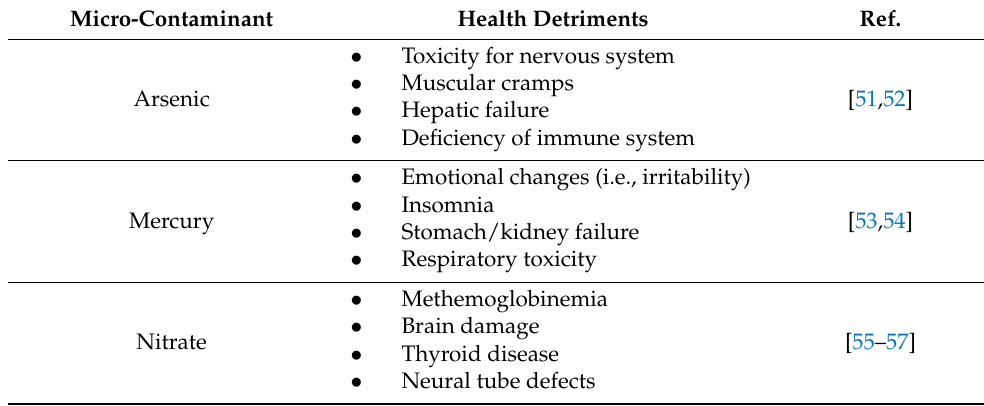
Table 2. The potential detriments of micro-contaminants on the